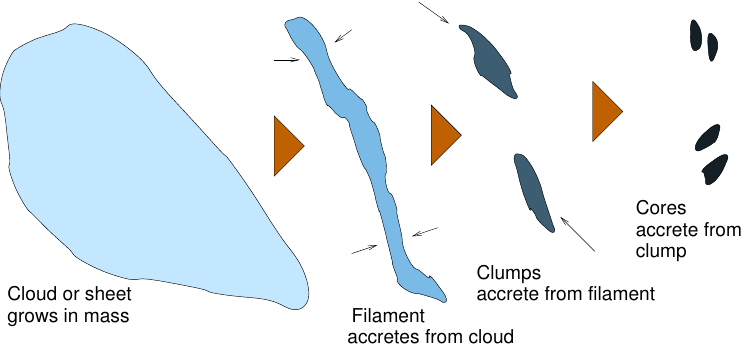
Figure 6. Illustration of the hierarchical collapse proceeding from large to small scales (see the